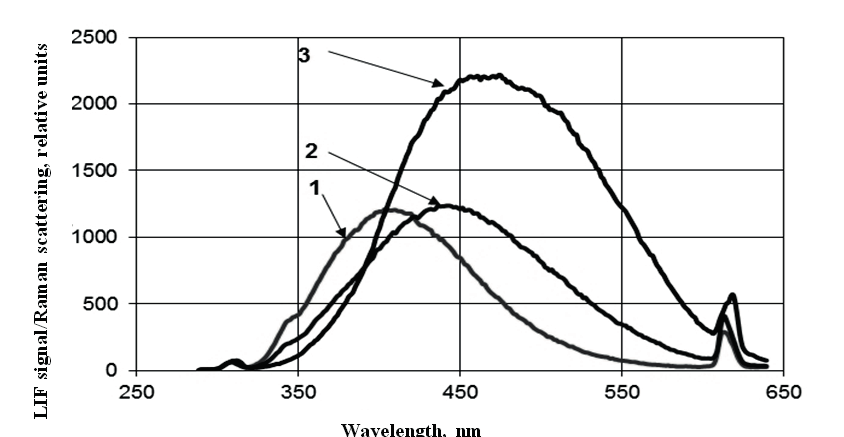
Fig. 8 LIF spectra of oil on the ice surface: 1 − clear ice; 2 − thin spots of oil on the ice surface (diameter of the spot ~1 mm); 3 − thin layer of oil on the ice surface.